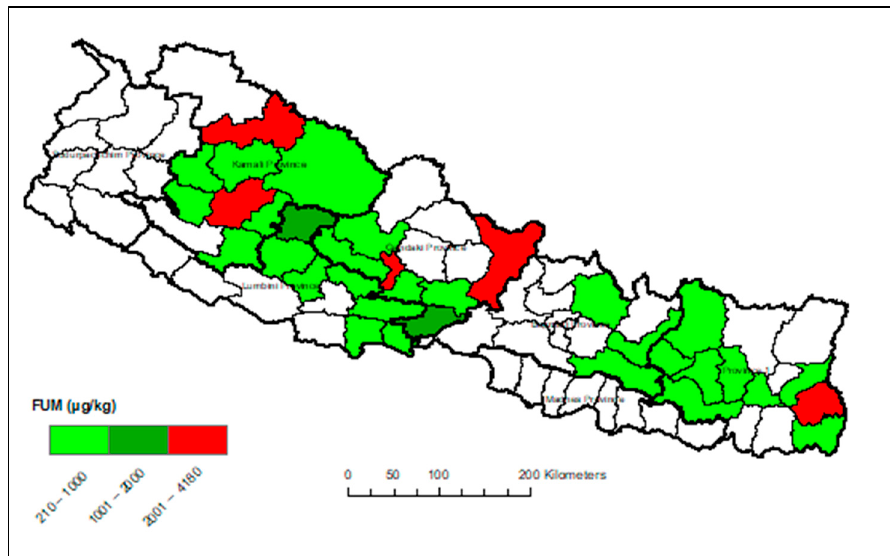
Figure A4. Heat map of FUM occurrence in Nepalese maize. The range of found concentration of FUM is shown in light green, dark green and red colors, representing the concentrations ranging from low to high, and red indicating the areas exceeding the EU maximum limit. FUM was found in concentrations of 200 to 4180 µg/kg.